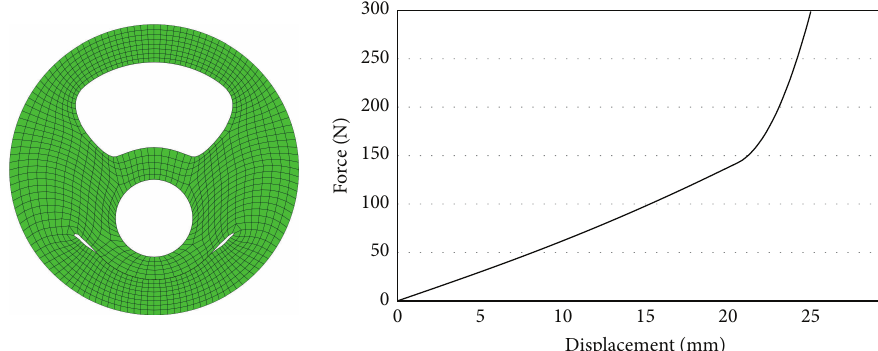
Figure 7: Deformed model and radial stiffness curve.